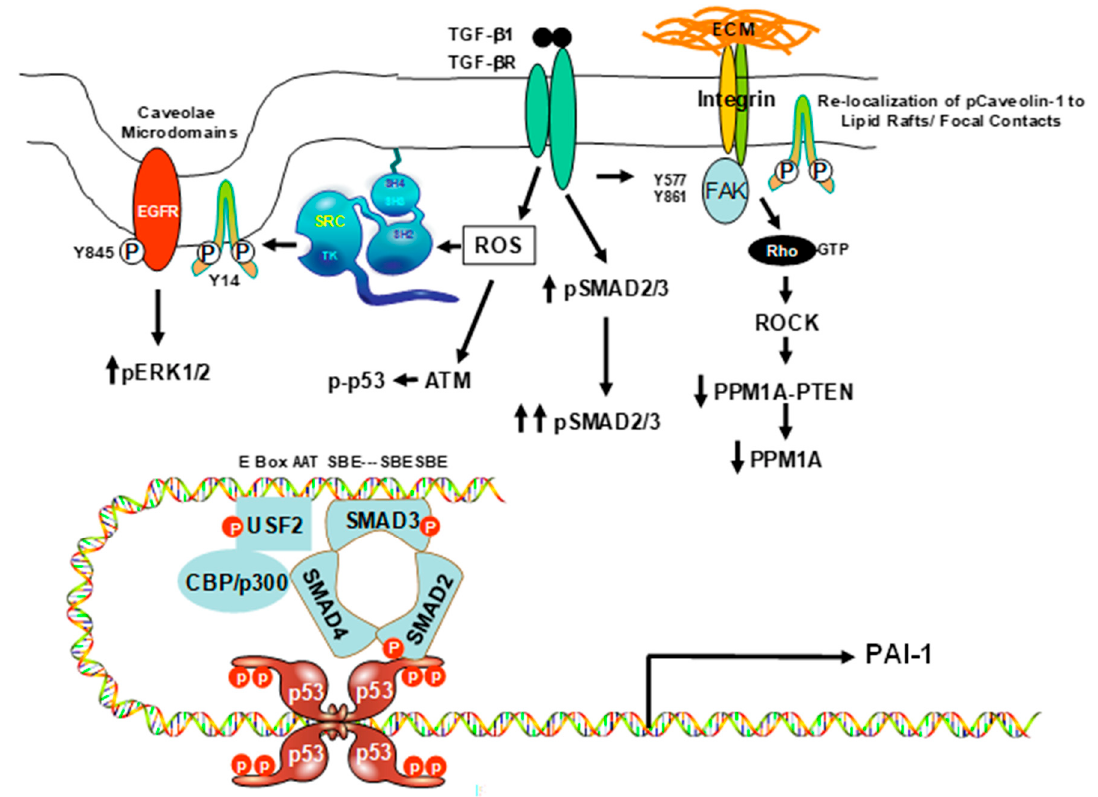
Figure 2. A model illustrating the maintenance of induced SMAD3 phosphorylation and PAI-1 transcription in response to TGF- β 1 via Src / p53 / FAK / Caveolin-1 signaling. Binding of TGF- β 1 to the TGF- β receptor (TGF- β R) stimulates the generation of reactive oxygen species (ROS) and activates Src kinases. Src phosphorylates caveolin-1 at Y14 and transactivates the EGFR at the Src target Y845 residue, leading to mobilization of the MEK-ERK and p38 (not shown) pathways. TGF- β 1-initiated Src